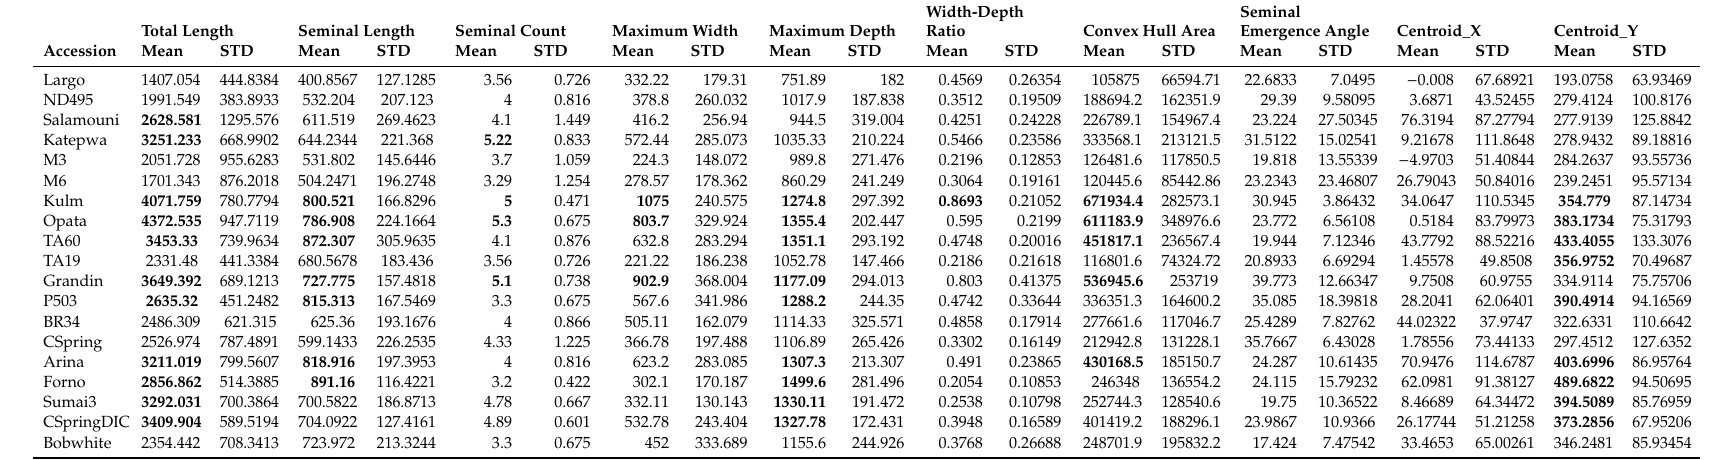
Table 2. Root system architecture traits measured in 19 wheat accessions (hexaploid). The bolded mean values showed level of significance at p < 0.05 compared to the reference accession (Largo). Each trait has a column representing the mean value of 10 replicates for each accession followed by their standard